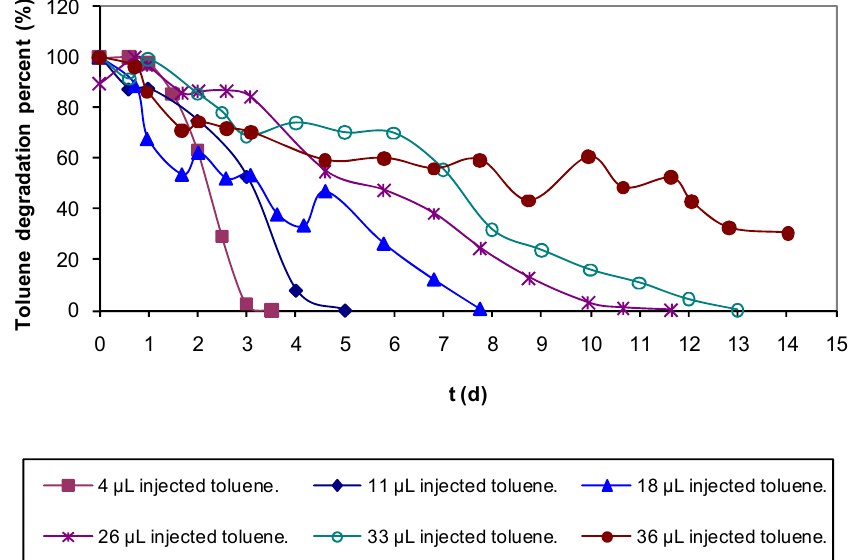
Figure 2. Batch assays performed to study biodegradation rates for different toluene total injected volumes at 20 °C and with 0.3 g VSS L − 1 giving an optical density of 0.70 A (all the assays by